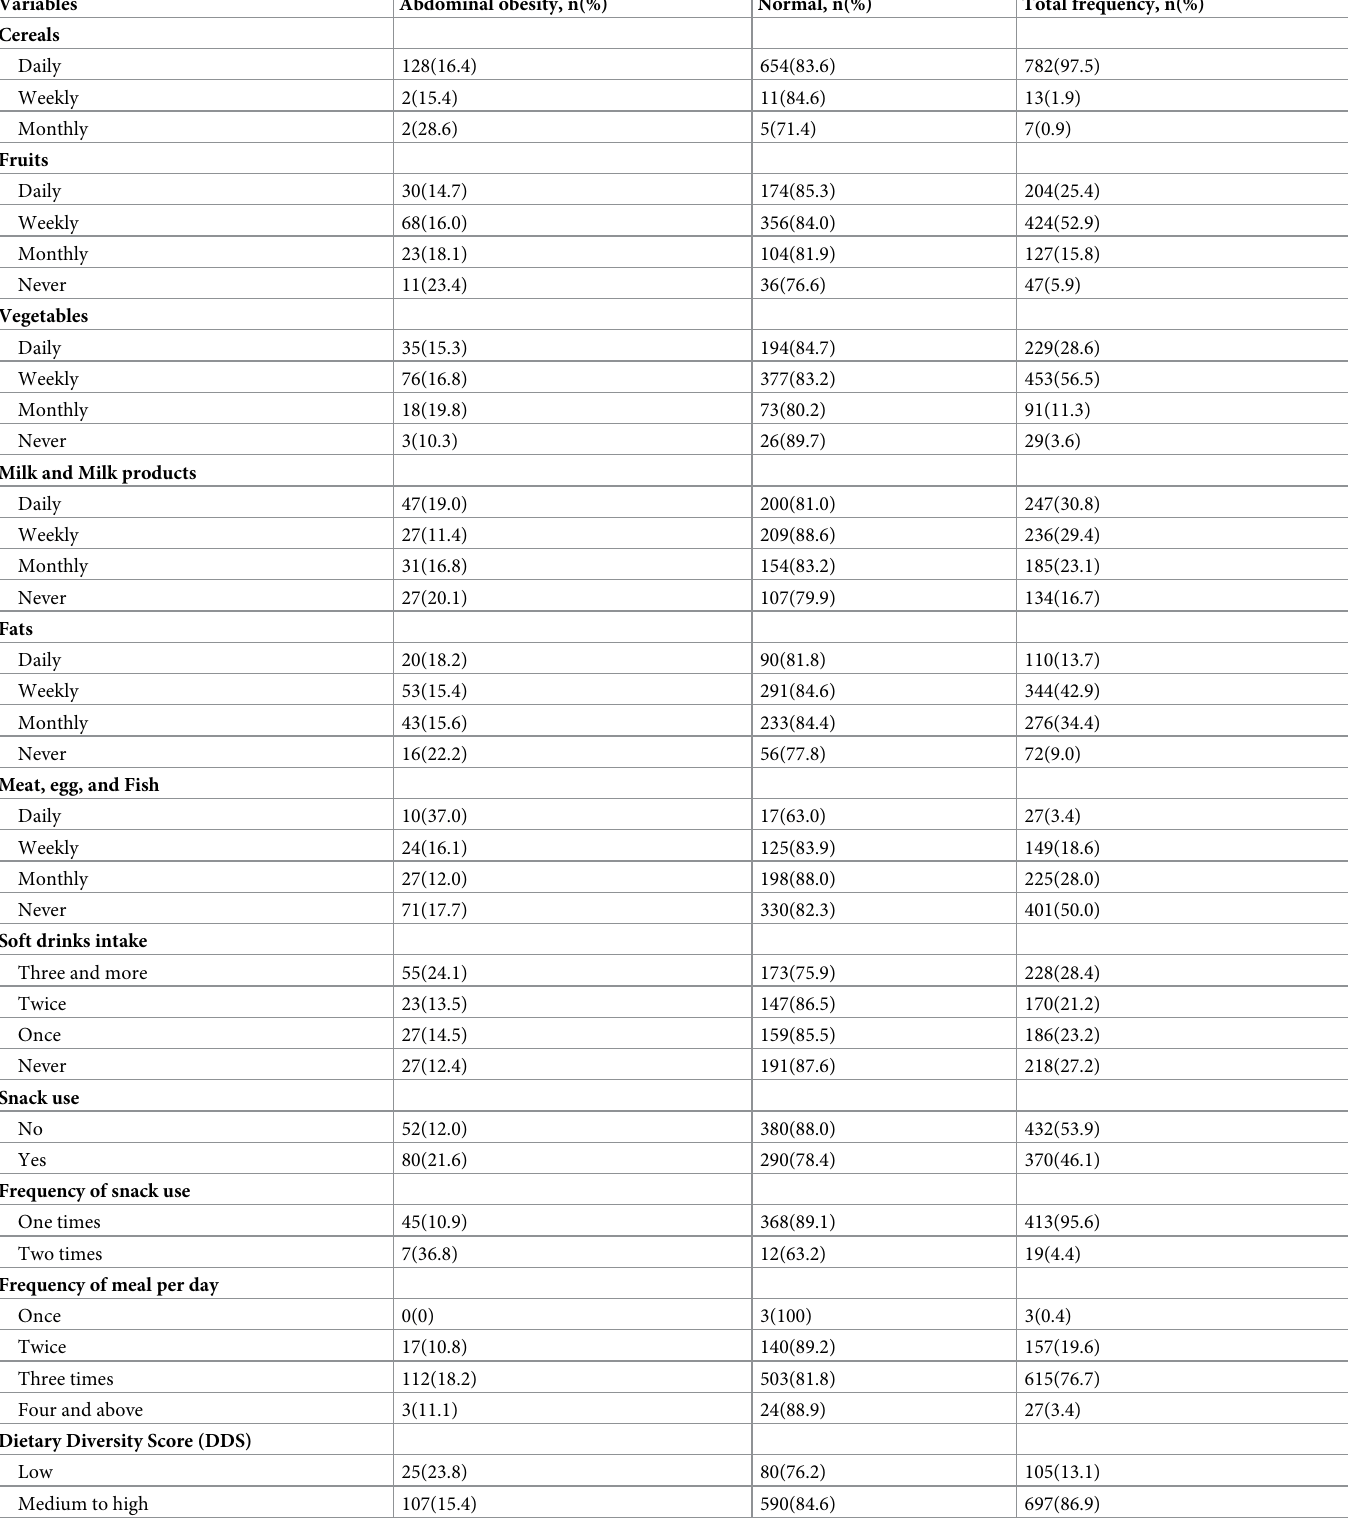
Table 2. Dietary habits among adult population in Woldia town, Northeast Ethiopia,